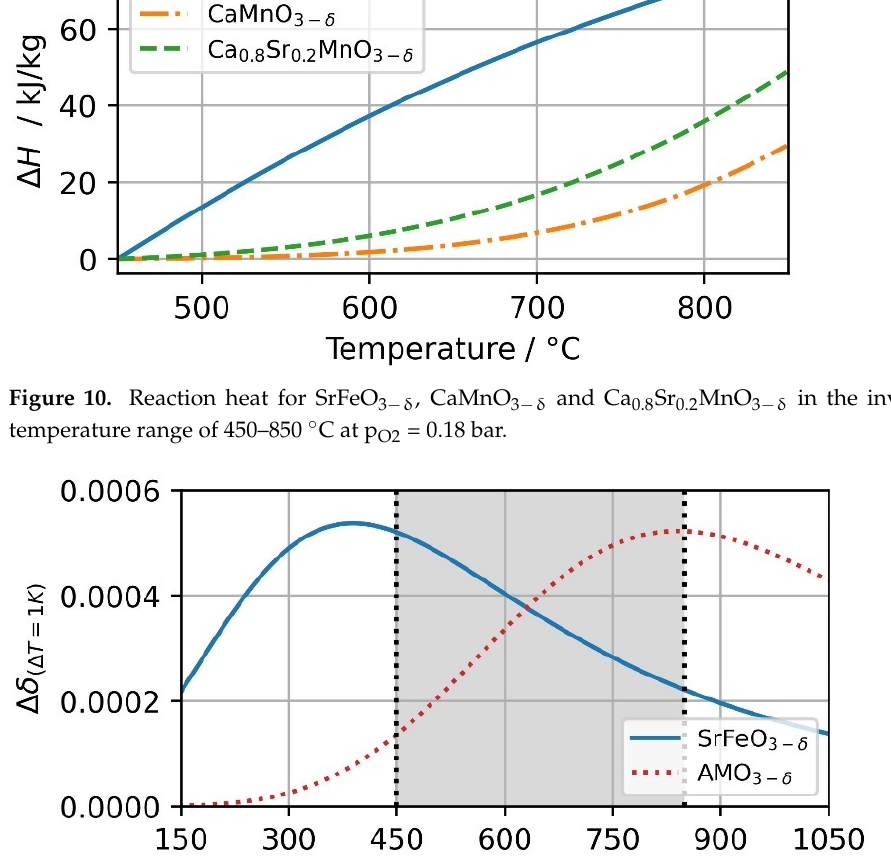
Figure 11. Change in non-stoichiometry ∆ δ based on temperature change of 1K at p O2 = 0.18 bar. The change of SrFeO 3 − δ and a hypothetical AMO 3 − δ perovskite is visualized over a temperature range from 150 to 1050 °C.